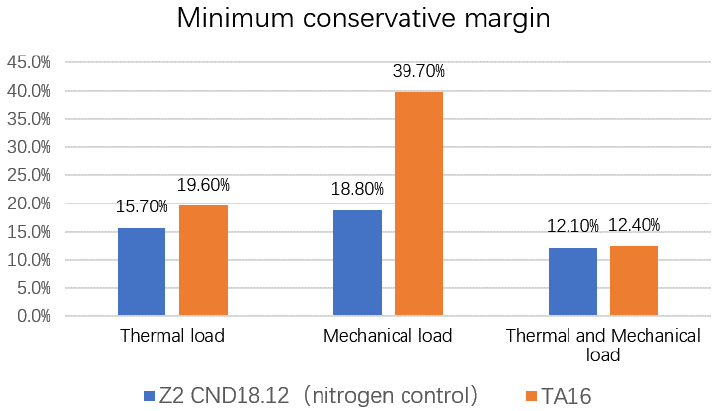
Figure 14. The minimum conservative margin of TA16 and Z2CND18.12 (nitrogen control).